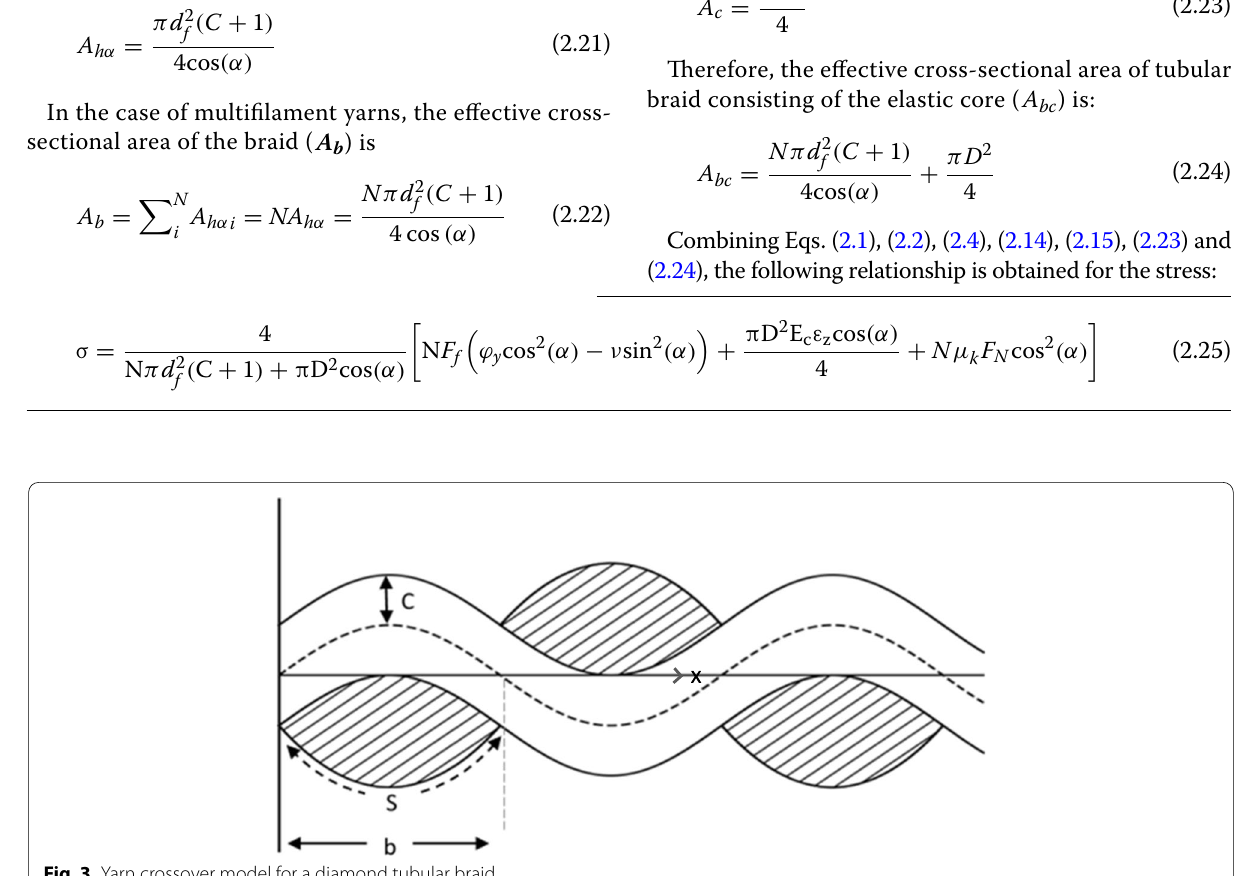
Fig. 3 Yarn crossover model for a diamond tubular braid